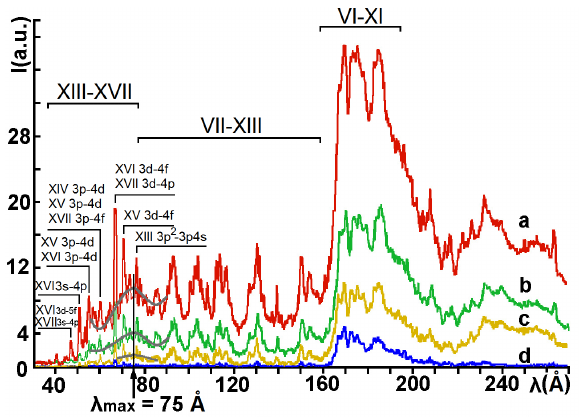
Fig. 4. Emission spectra of the Fe discharge plasma for U = 14 kV, J = 250 mJ (a); 14 kV, 130 mJ (b); 14 kV, 80 mJ (c); and 8 kV, 80 mJ (d). The arrow shows the approximate position λ max ≈ 75 Å of the maximum of the averaged spectrum in the 30–90 Å